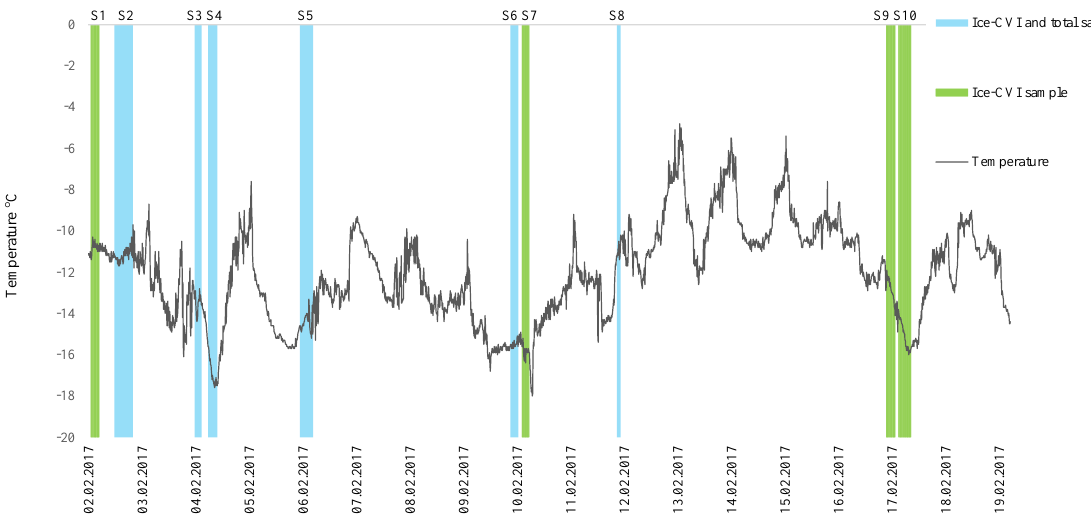
Figure 2. Temperature ( ◦ C) and sampling times in February 2017 behind Ice-CVI and total inlet. Sample numbers are given above the bars. Blue bars indicate sampling periods with parallel samples, and green bars periods for which only IR samples could be analysed. Temperature data were received from the Federal Office of Meteorology and Climatology (MeteoSwiss; https://www.meteoswiss.admin.ch, last access: 17 October 2017